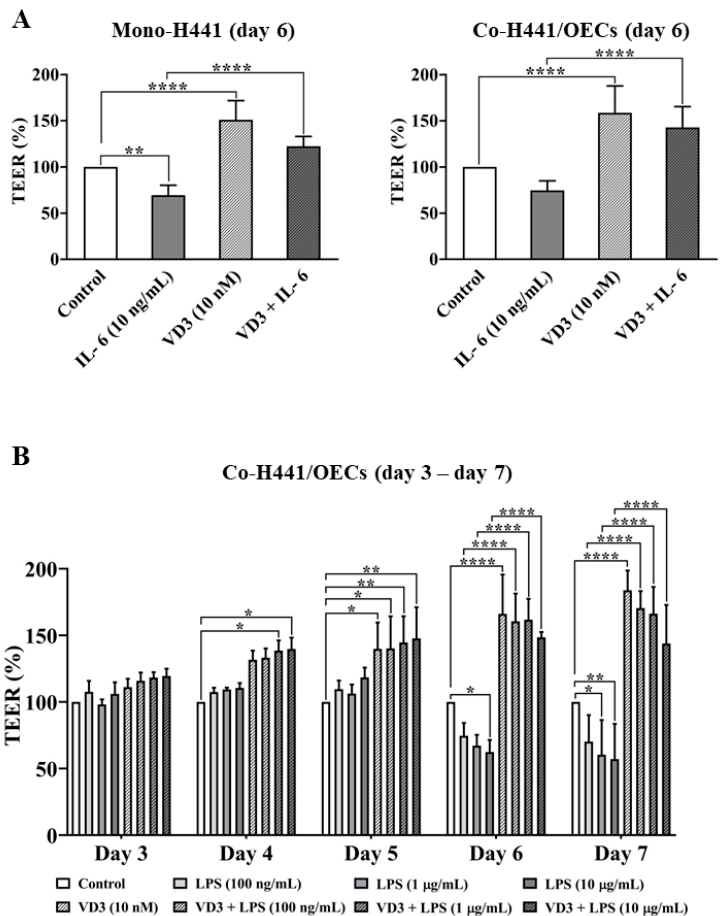
Figure 2. TEER measurement from the Transwell ® systems to investigate the effects of VD 3 (10 nM) on the barrier integral resistance. ( A ) TEER measurement on day 6 of the mono-culture of NCI-H441 cells and co-culture of NCI-H441/OECs treated with VD 3 (10 nM) and IL-6 (10 ng/mL). ( B ). Temporal development of TEER from day 3 to day 7 of the co-culture of NCI-H441/OECs treated with VD 3 (10 nM) and di ff erent doses of LPS (100 ng/mL, 1 µg/mL, 10 µg/mL). The treatment was performed as depicted schematically in Figure 1 for IL-6 or LPS in independent experiments. The measured TEER values were analyzed as relative ratios in percentage (%) in comparison with the control group and shown as mean values ± SD from at least three independent experimental sets ( n ≥ 3). * p ˂ 0.05, ** p ˂ 0.01, **** p ˂ 0.0001, two-way ANOVA.